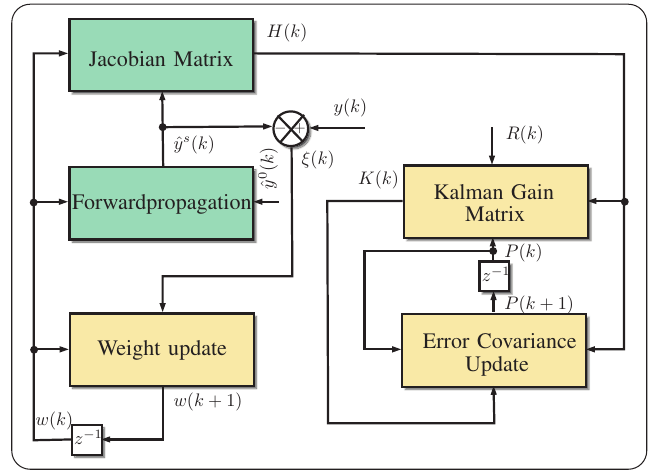
Figure 1. Block diagram of the EKF algorithm.